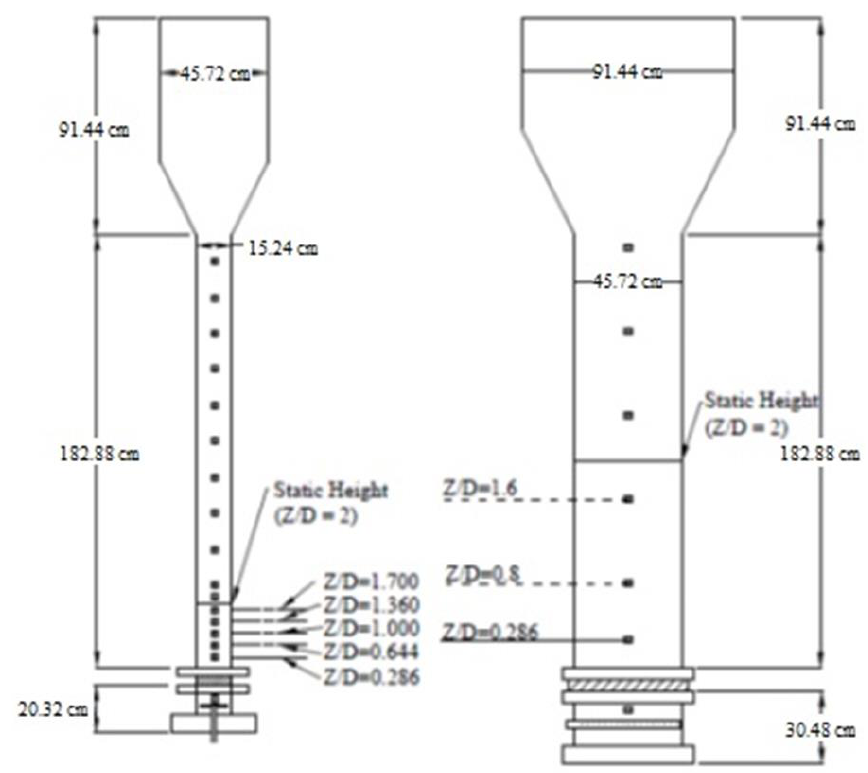
Figure 1. Schematic of detailed dimensions of 0.14 m and o.44 m Fluidized Beds along with the dimensionless axial measurement levels.